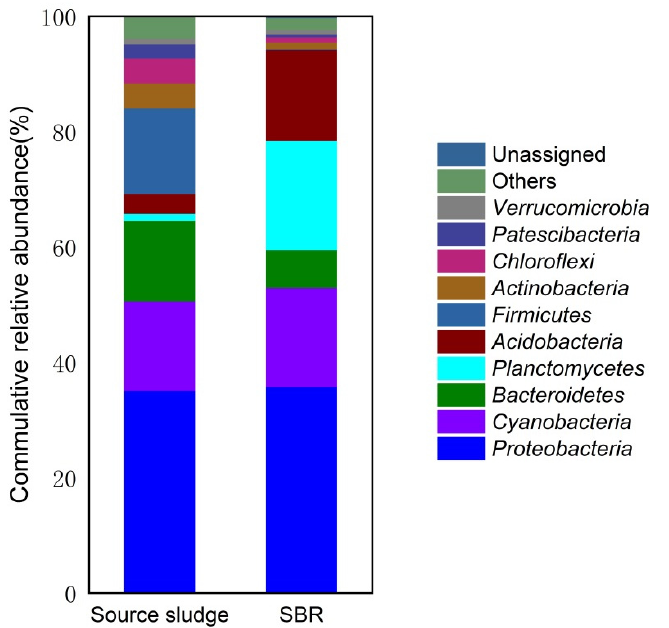
Figure 4. Cumulative relative abundance (%) of the detected phylum in the source sludge and SBR communities (a total of 10 dominant microbial phyla were detected in both samples).